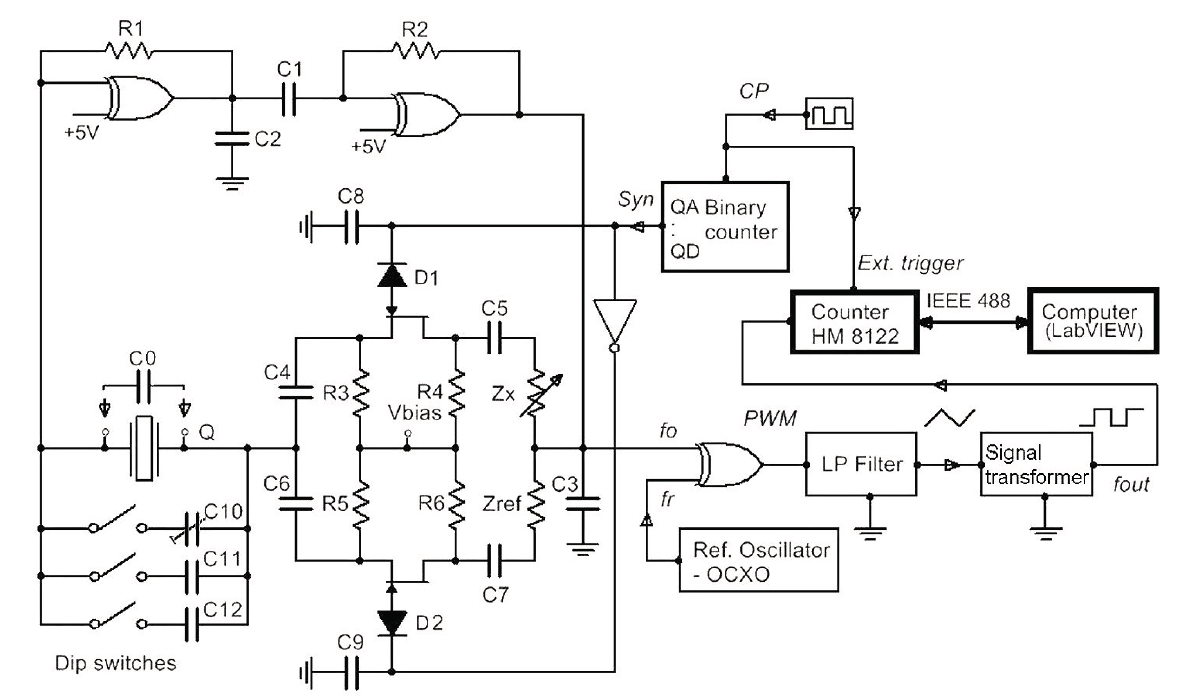
Figure 1. Schematic representation of the inductance-to-frequency